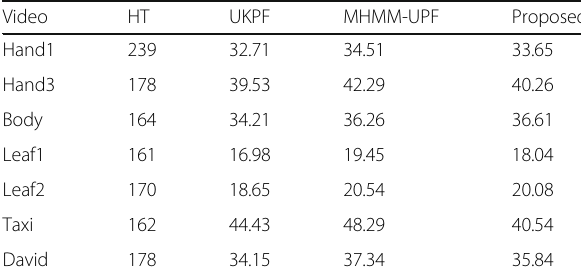
Table 4 Time consumption (ms) of tested algorithms